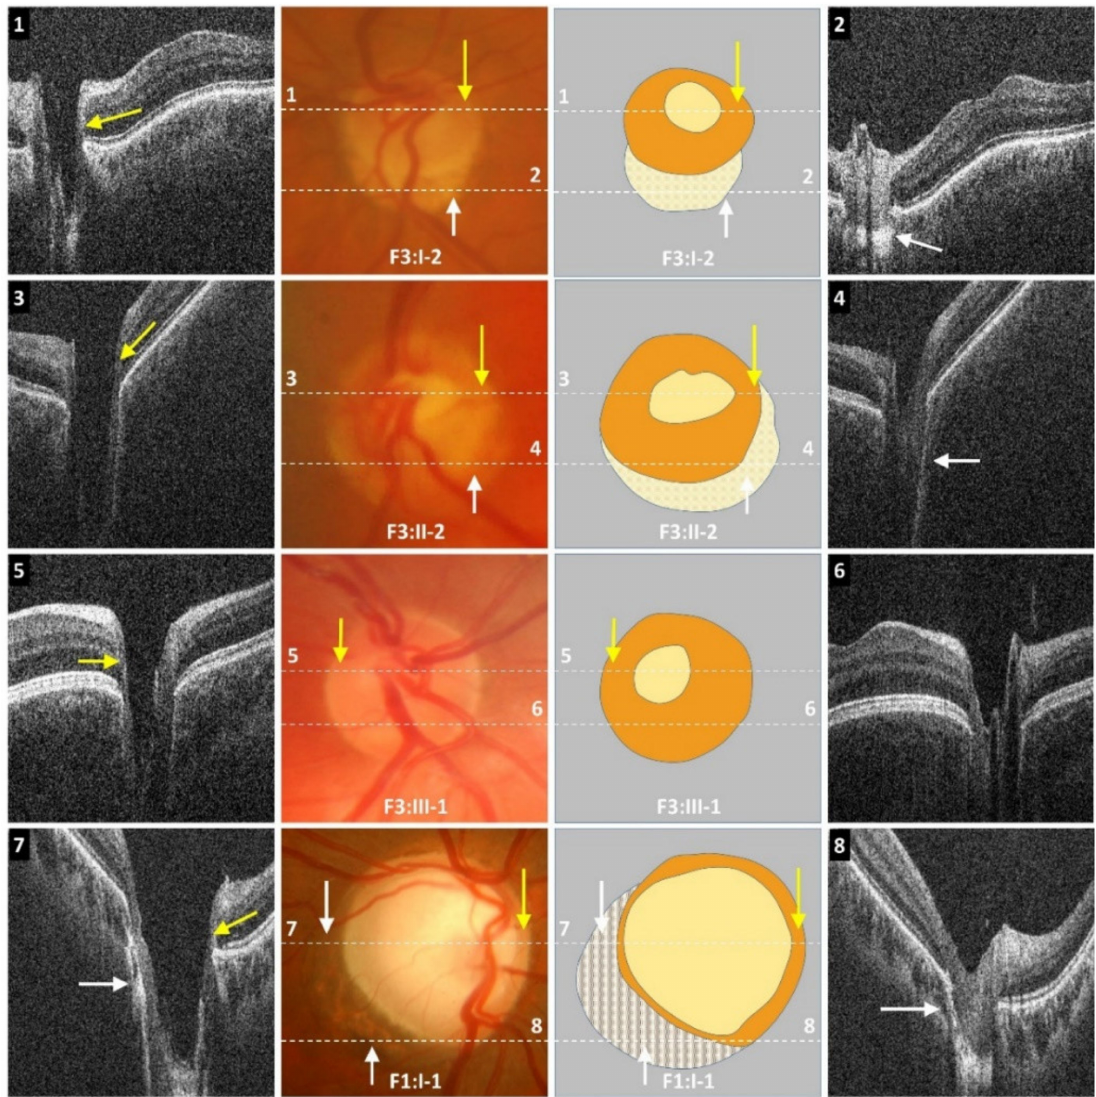
Figure 3. Optical coherence tomograms with corresponding disc photos. Dotted white line represents location of the OCT B-scan overlaid on the disc photo. Schematic shows borders of disc (orange) with the cup centrally (yellow), double ring (pale yellow), and peripapillary atrophy (hatched). Partial double ring/atrophy (F3:I-2 and F3:II-2) is seen below disc border (white arrows). In subject F3:I-2, the first scan ( 1 ) shows thin temporal neuro-retinal rim (yellow arrow); this is not evident on the disc photo as the borders of the cup are not clear and the cup appears significantly smaller. The location of the neuro-retinal rim on the fundus photo is highlighted with the yellow arrow. The second scan ( 2 ) is through a region of yellow mottled appearance. The OCT shows a hyper-reflective region posteriorly (white arrow). Disc photo of subject F3:II-2 shows appearance of a small cup. However, on OCT ( 3 ) the rim is very thin (yellow arrow), and the cup is deep and appears larger than on the fundus photo. The OCT through the inferior aspect of the disc ( 4 ) shows an optic cup that is not evident on the fundus photo. Disc photo in F3:III-1 shows a small cup with large neuro-retinal rims. However, OCT ( 5 ) shows thin neuro-retinal rim temporally (yellow arrow). OCT ( 6 ) below the inferior border of the presumed cup (from the fundus photo and illustration) shows a well-formed cup, although not as deep as the OCT through the center of the cup ( 5 ). In subject F1:I-1, this abnormal sloping is evident in the region of peripapillary atrophy (white arrow) in both scans ( 7 , 8 ). There is also a thin neuro-retinal rim with good correlation between disc photos and the OCT (yellow